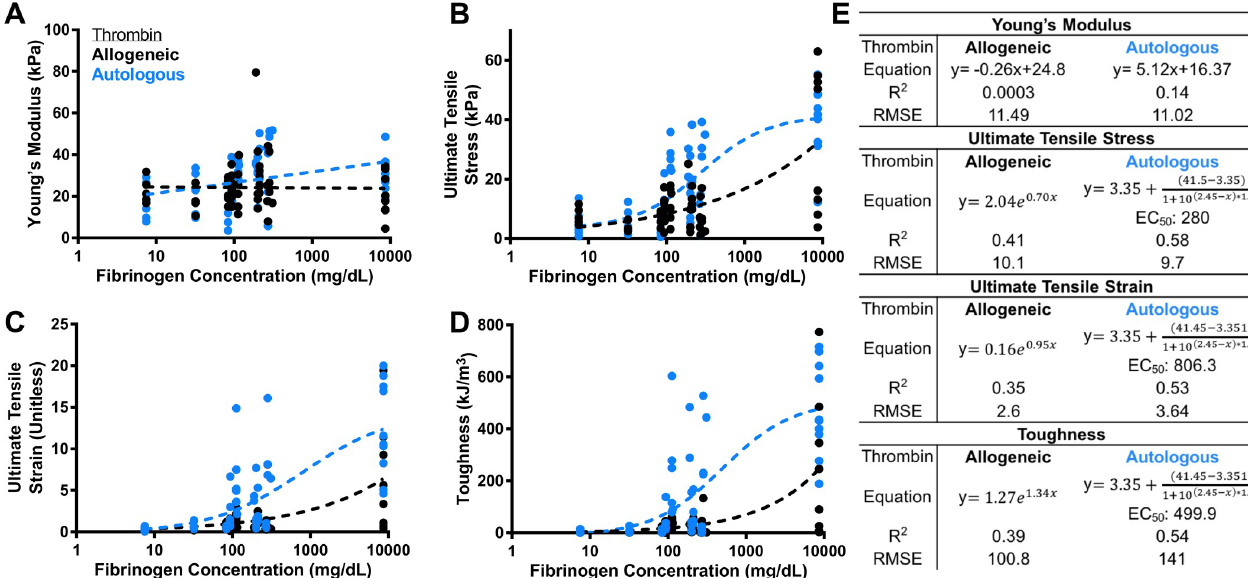
Fig 5. Failure properties improve with increased fibrinogen concentration. Young’s Modulus (A) and failure properties (B-D) plotted as functions of fibrinogen concentration. Strains are unitless. Fibrin sealants fabricated from allogeneic thrombin shown in black, and those fabricated from autologous thrombin shown in blue. Each individual sample represented by a data point. Fit parameters and goodness of fit measurements are summarized in panel (E).